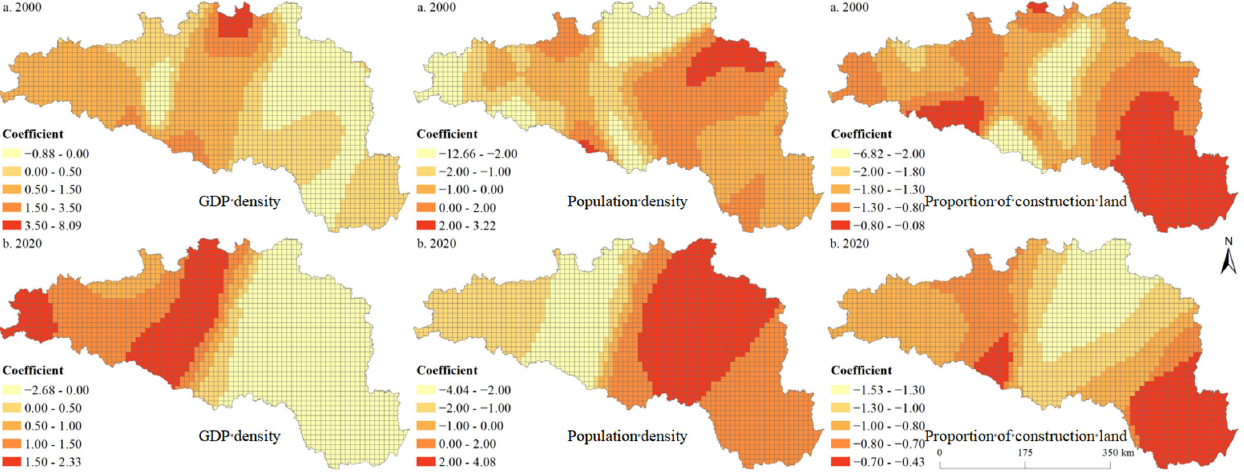
Figure 9. Spatial distribution of the regression coefficient of urbanization elements at the 10 km grid scale in the HREEB in China.